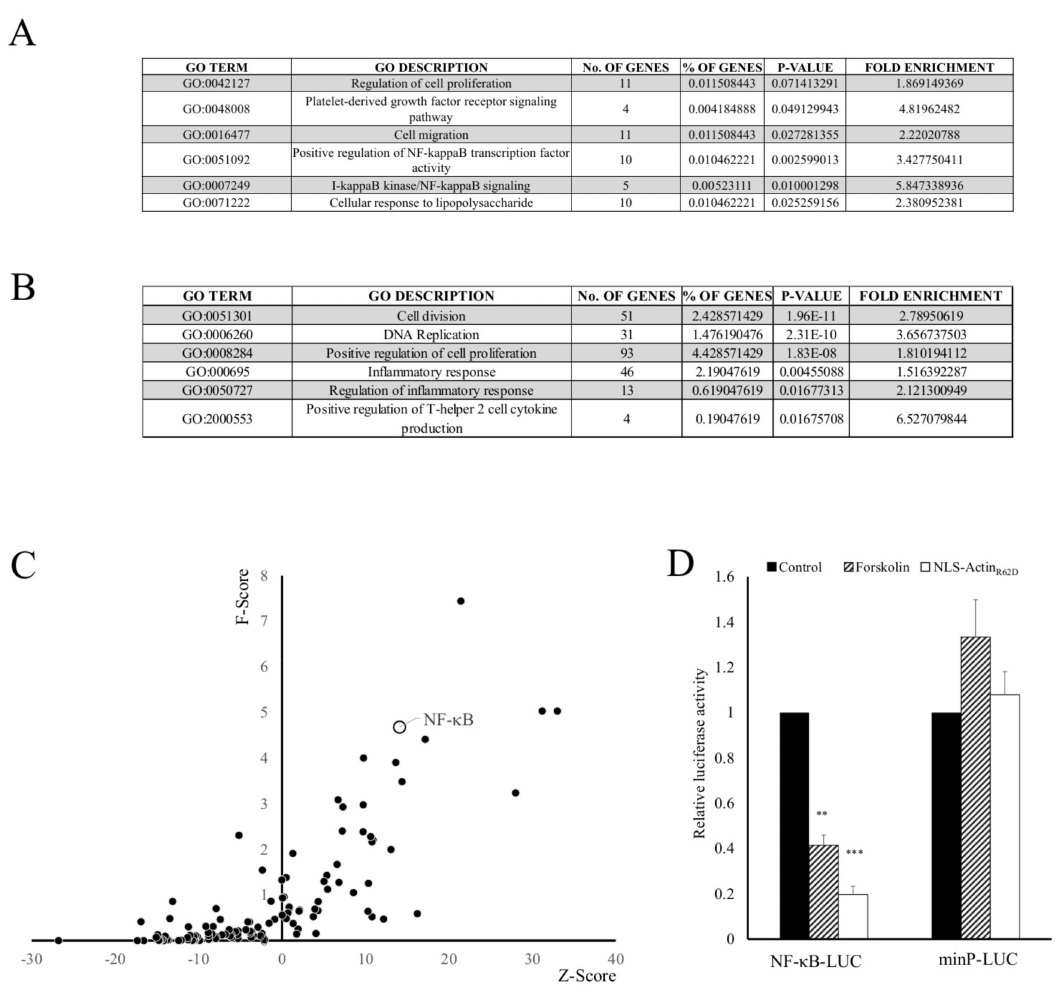
Figure 1. Gene Ontology and transcription factor element enrichment analysis of forskolin and nuclear actin monomer-repressed transcriptome identifies enrichment of inflammation related GO- terms and NF- κ B binding elements. Gene Ontology analysis of genes identified by RNA-seq as being significantly repressed by a 6-h stimulation with 25 µ M forskolin in VSMC ( A ). Gene Ontology of genes identified by RNA-seq as significantly repressed by expression of NLS-Actin R62D in VSMC ( B ). Transcription factor enrichment analysis of − 1000bp promoter regions of NLS-Actin R62D repressed genes ( C ). VSMC were transfected with either a NF- κ B-dependent luciferase reporter gene (NF- κ B- LUC) or a luciferase reporter gene driven by a minimal promoter lacking NF- κ B elements (minP-LUC). Luciferase activity was quantified after 6-h stimulation with 25 µ M forskolin or 24 h after infection with a control adenovirus or an adenovirus expressing NLS-Actin R62D ( D ). ** indicates p < 0.01, *** indicates p <